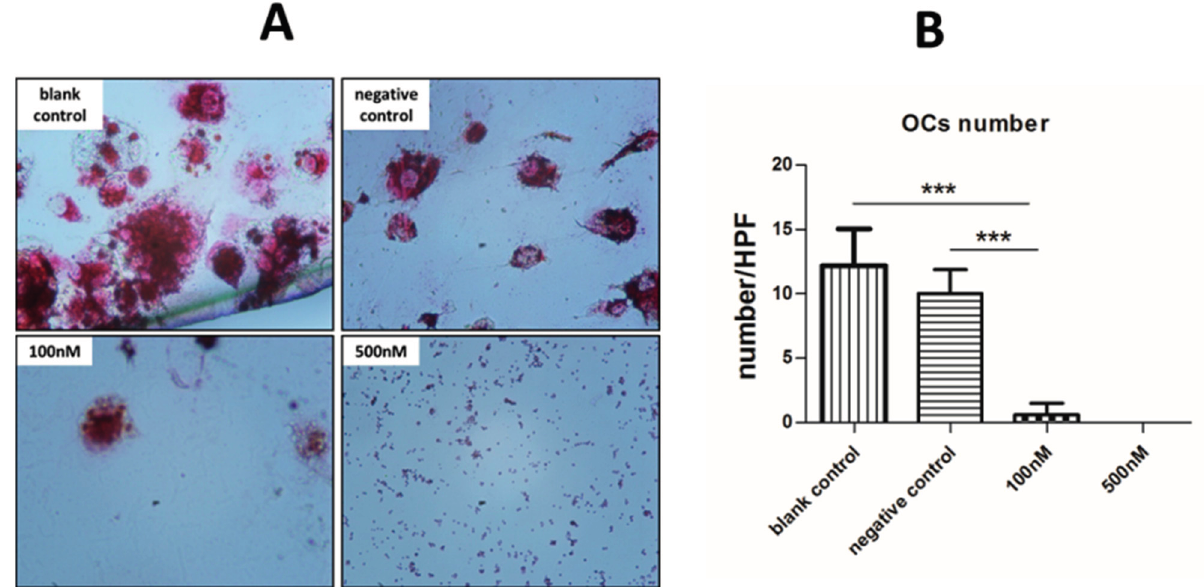
Figure 4. TRAP staining for measurement of the formation of OCs. ( A ) Typical OCs, defined as TRAP-positive and multinucleate cells, were observed by microscopy (original magnification 200×); and ( B ) Five high-power fields were randomly selected for each group and the number of OCs were counted. We then calculated the average number of each group to compare the statistical differences. *** p < 0.001. Each experiment was carried out in